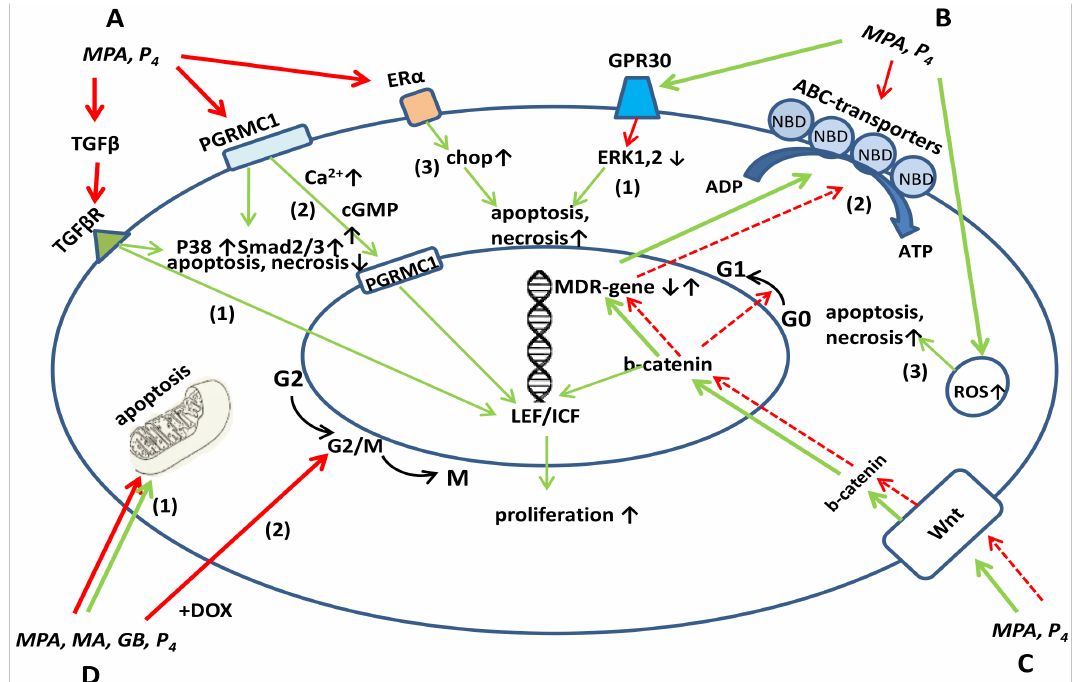
Figure 1. Influence of progestins on signaling pathways leading to the proliferation, apoptosis and drug resistance. ( A ). Progesterone and progestins decrease the TGF- β production and expression of TGF- β -target genes SMAD, P38, NFkB, RAS, PI3K (1), decrease PGRMC1 expression, which attenuates the Ca 2+ - and cGMP-mediated proliferative signals to the nucleus and the PGRMC1-mediated resistance to drugs (2), cause ER down-regulation, decrease estrogen-linked mitosis, and increase CHOP and FOXO1 expression, thereby inducing apoptosis and necrosis (3). ( B ). Progestins promote apoptosis and necrosis by down-regulating ERK-1,2 through GPR30 (1); inhibit the expression and transport activity of MDR-related proteins P-gp, BCRP, MRP through the interaction with the nucleotide-binding domain (NBD) (2); cause ROS formation and apoptosis (3); ( C ). Progestins at low concentrations promote (solid line) and at high concentrations (dashed line) inhibit Wnt signaling linked through the MDR-promoter element with MDR. ( D ). Progestins suppress cell cycle progression at the G o G 1 checkpoint and in combination with cytostatics (DOX) induce G2/M block (1), regulate the MPTP opening and mitochondrial-dependent apoptosis (2). Green line-activation, red line-inhibition of indicated